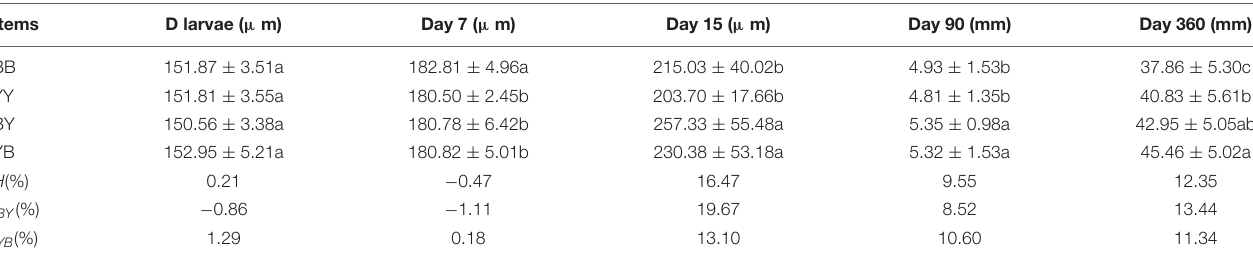
TABLE 4 | Growth index of of two strain’s progeny (BB and YY) and their reciprocal hybrids (BY and YB), at different days post-fertilization, as well as heterosis ( H and I ).